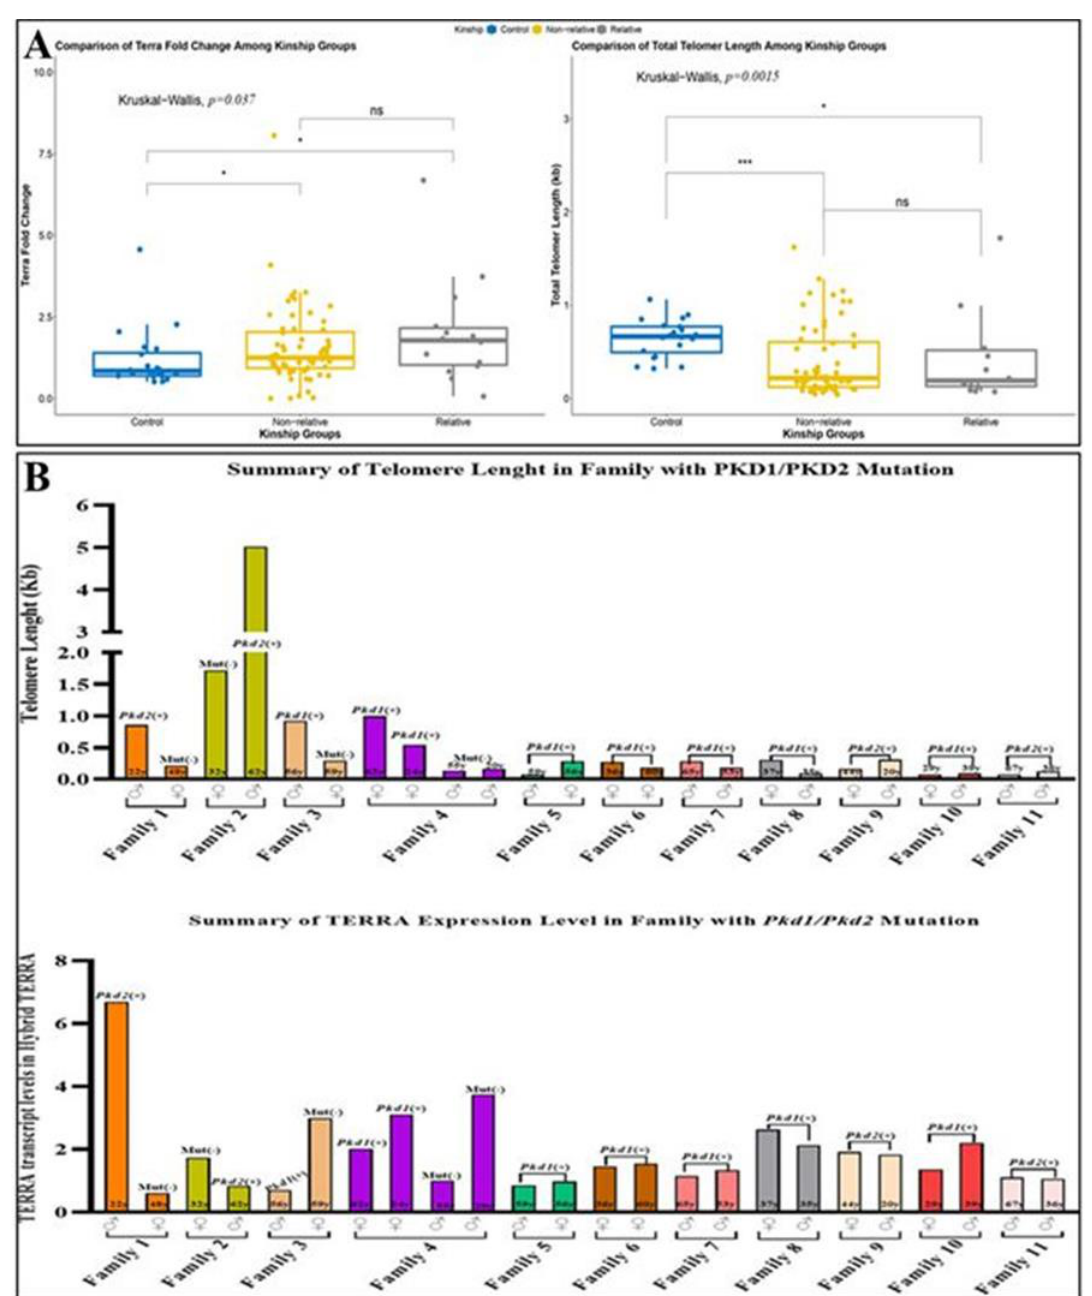
Figure 5. Assessment of relative and nonrelative ADPKD patients in terms of TERRA levels and telomere lengths (* p = 0.037, *** p = 0.0015) ( A ). Comparison of telomere lengths and hybrid TERRA levels of individuals among ADPKD families according to PKD1/2 mutations ( B ).